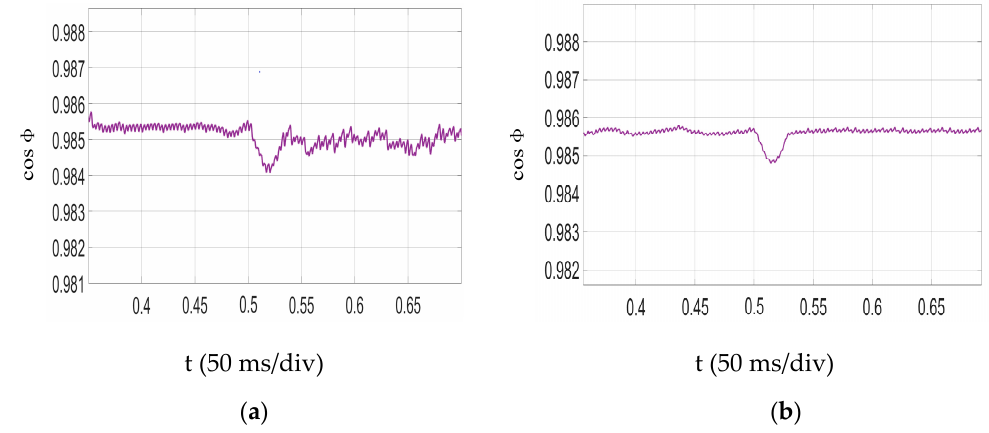
Figure 12. Power factor on the AC input side when the load suddenly decreases: ( a ) Controlled by backstepping control method; ( b ) Controlled by SMVS.